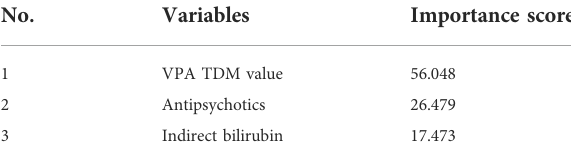
TABLE 3 Importance scores of